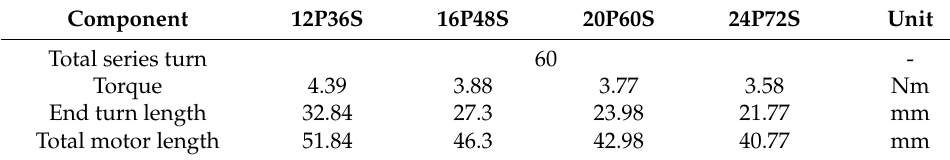
Figure 4. Analysis model and end turn length according to pole slot combination: ( a ) 12P36S; ( b ) 16P48S; ( c ) 20P60S; ( d ) 24P72S. Table 3. Comparison with the characteristics according to pole slot